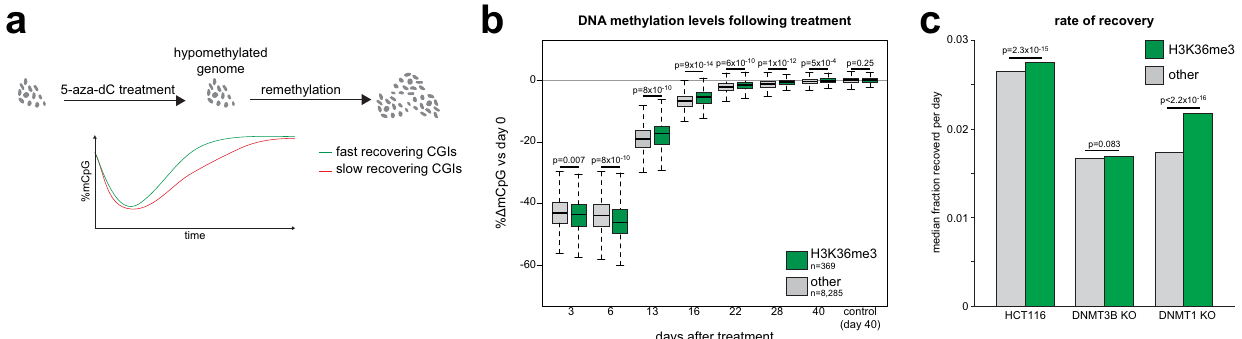
Fig. 4 H3K36me3 marked CGIs preferentially recover methylation following pharmacological hypomethylation. a Schematic of experimental approach. 5-aza-dC is used to hypomethylate cells and the kinetics of methylation recovery are compared for different CGIs. b H3K36me3 marked CGIs preferentially recover methylation following 5-aza-dC treatment. Boxplots of relative methylation at H3K36me3 marked CGIs ( n = 369) and all other CGIs methylated ( n = 8285) in HCT116 cells. P -values are from two-sided Wilcoxon rank sum tests. Lines = median; box = 25th – 75th percentile; whiskers = 1.5 × interquartile range from box. c The rate of methylation gain is higher at H3K36me3 CGIs in HCT116 cells. Barplot of the median normalised rate of methylation gain for H3K36me3 marked CGIs and other CGIs methylated in HCT116 cells and DNMT KO cells ( n = 369, 371 and 284 for K36me3 CGIs and 8285, 8284 and 6519 for other CGIs in HCT116, DNM3B KO and DNMT1 KO, respectively). The rate of methylation recovery was estimated by fi tting linear models to the RRBS data for each CGI. P -values are from two-sided Wilcoxon rank sum tests. Source data are provided as a Source Data fi H3K36me3 marked CGIs recovered DNA methylation signi fi -